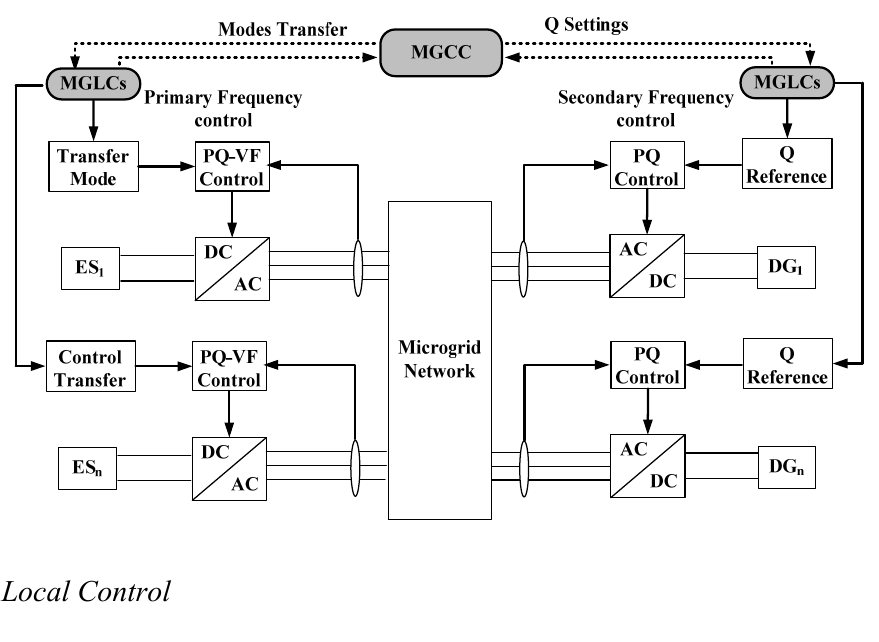
Figure 4. Two layered reactive power